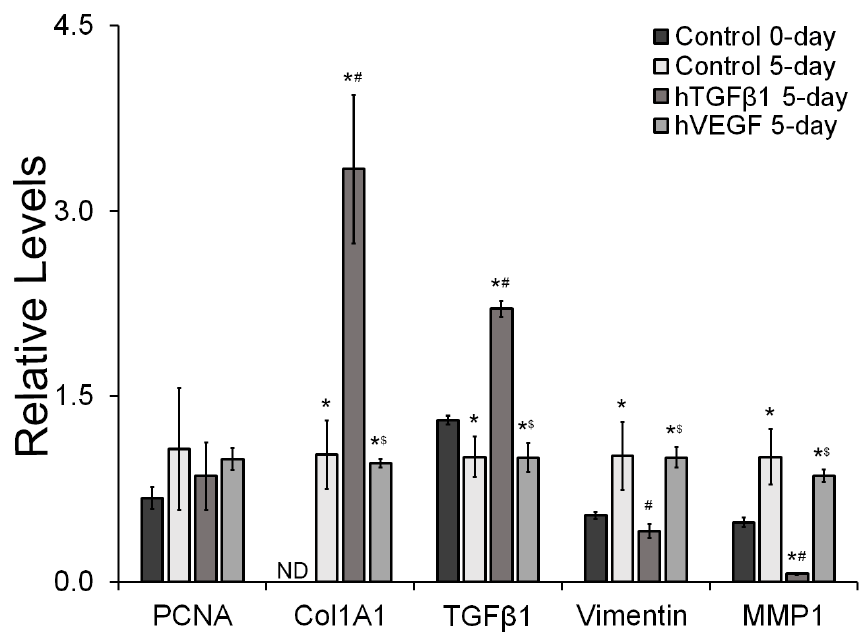
Figure 4. Phenotypical evaluation of HDFa using qRT-PCR. The expression of each marker was normalized relative to the 5-day control group. * Significantly different from 0-day control, p < 0.05, # Significantly different from 5-day control, p < 0.05, $ Significantly different from hTGF β 1, p < 0.05. ND, below the detection limit. n = 4.